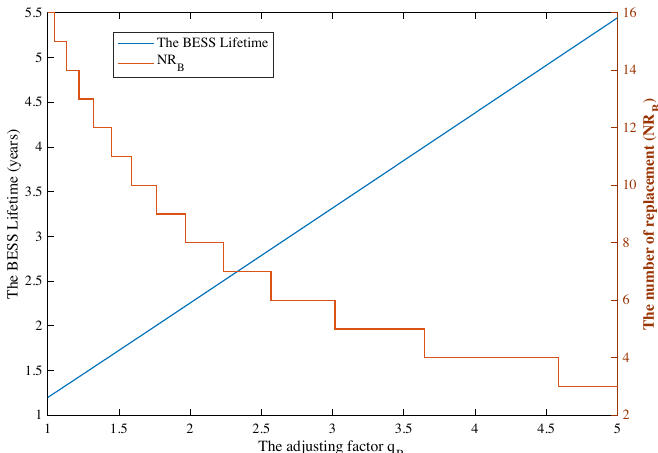
Figure 11. The BESS lifetime and the number of replacements for different values of q B